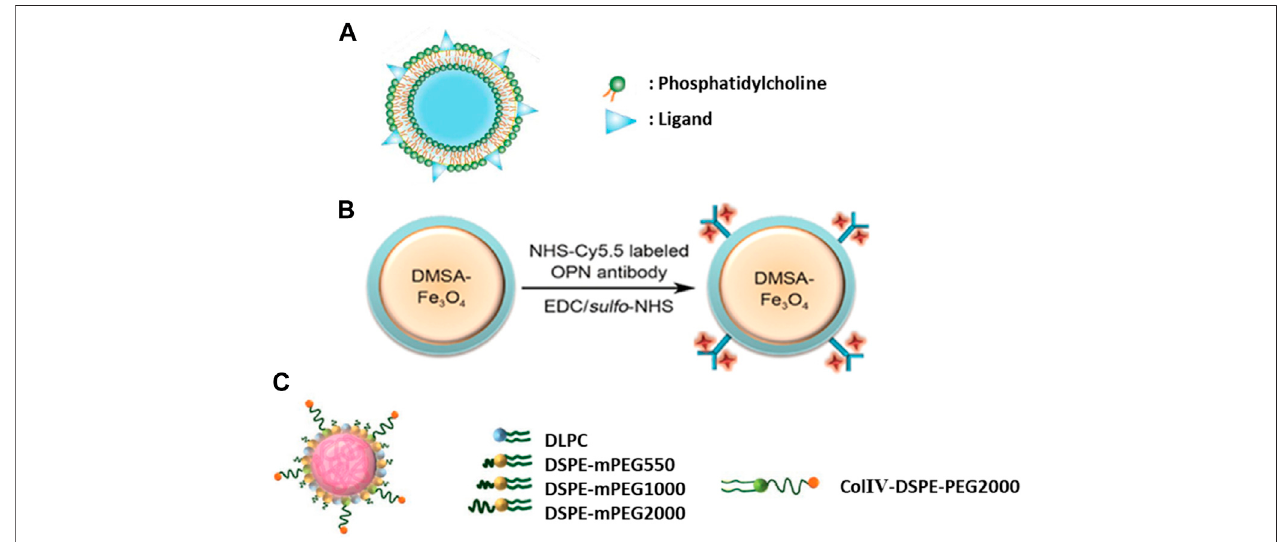
FIGURE 3 | (A) Liposome-like nanovesicle was prepared to target CD36 receptor through KOdiA-PC ligand (Copyright permission from Elsevier). (B) Iron oxide nanoparticles were conjugated with an anti-osteopontin antibody labeled with Cy5.5 fl uorescent dye for dual modality imaging of plaques (Copyright permission from Elsevier). (C) Lipid-polymer hybrid nanoparticles contained three components: a biodegradable hydrophobic polymeric core, a lipid layer and a peptide decoration for collagen IV (ColIV) targeting (Copyright permission from John Wiley &